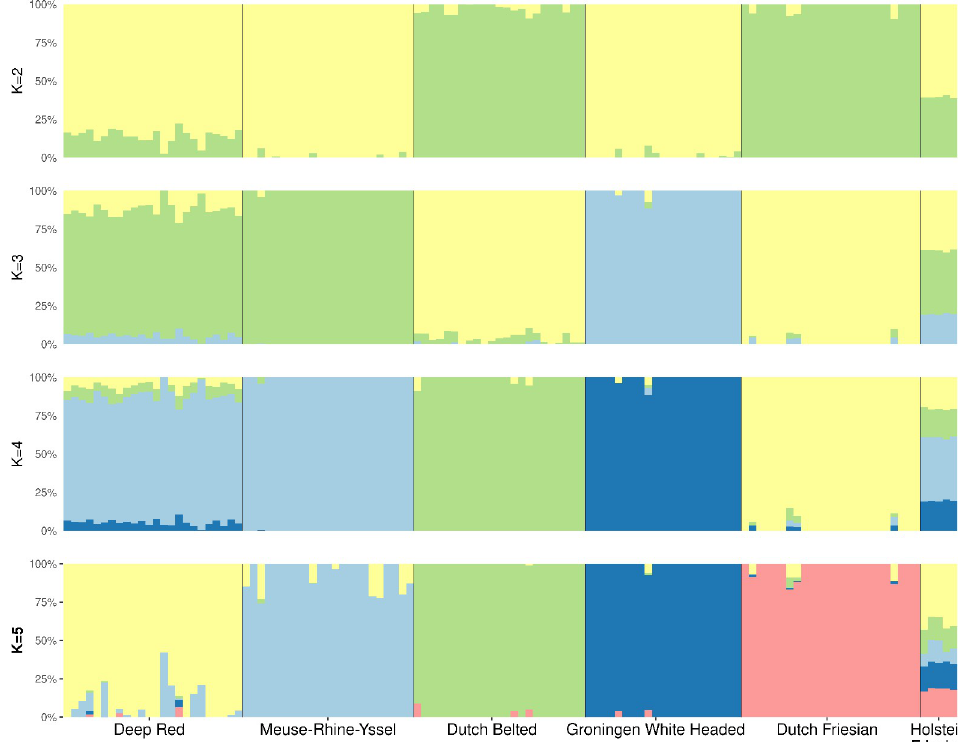
Fig 2. Population structure plot determined by the model-based clustering analysis of ADMIXTURE. Samples are represented by stacked columns of the 2 to 5 K-proportions and the number of clusters with the lowest cross validation error (CV = 0.54) was obtained for K =